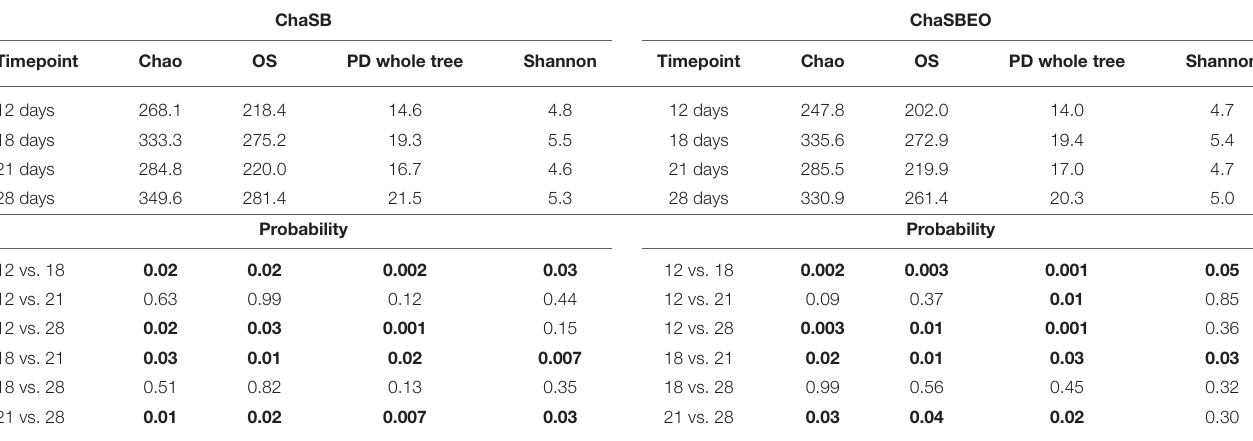
TABLE 3 | Alpha diversity indexes of the cecal microbiota of broiler chickens at different timepoints considering the necrotic enteritis challenged birds supplemented with sodium butyrate (SB) or sodium butyrate plus essential oils (SBEO). ChaSB ChaSBEO